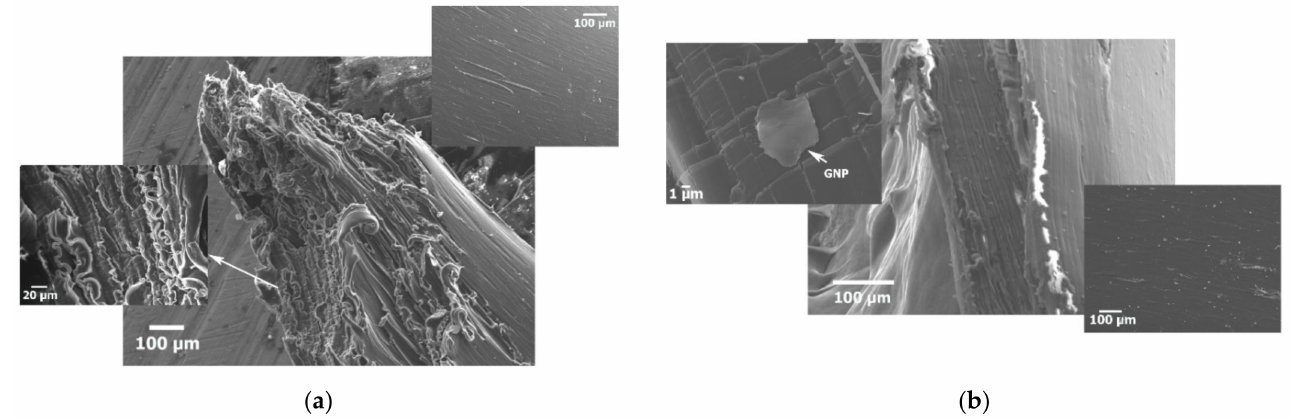
Figure 4. SEM images of the fracture surfaces of ( a ) SCB-PE/0.5 GNPs no BM and ( b ) SCB-PE/0.5 GNPs w